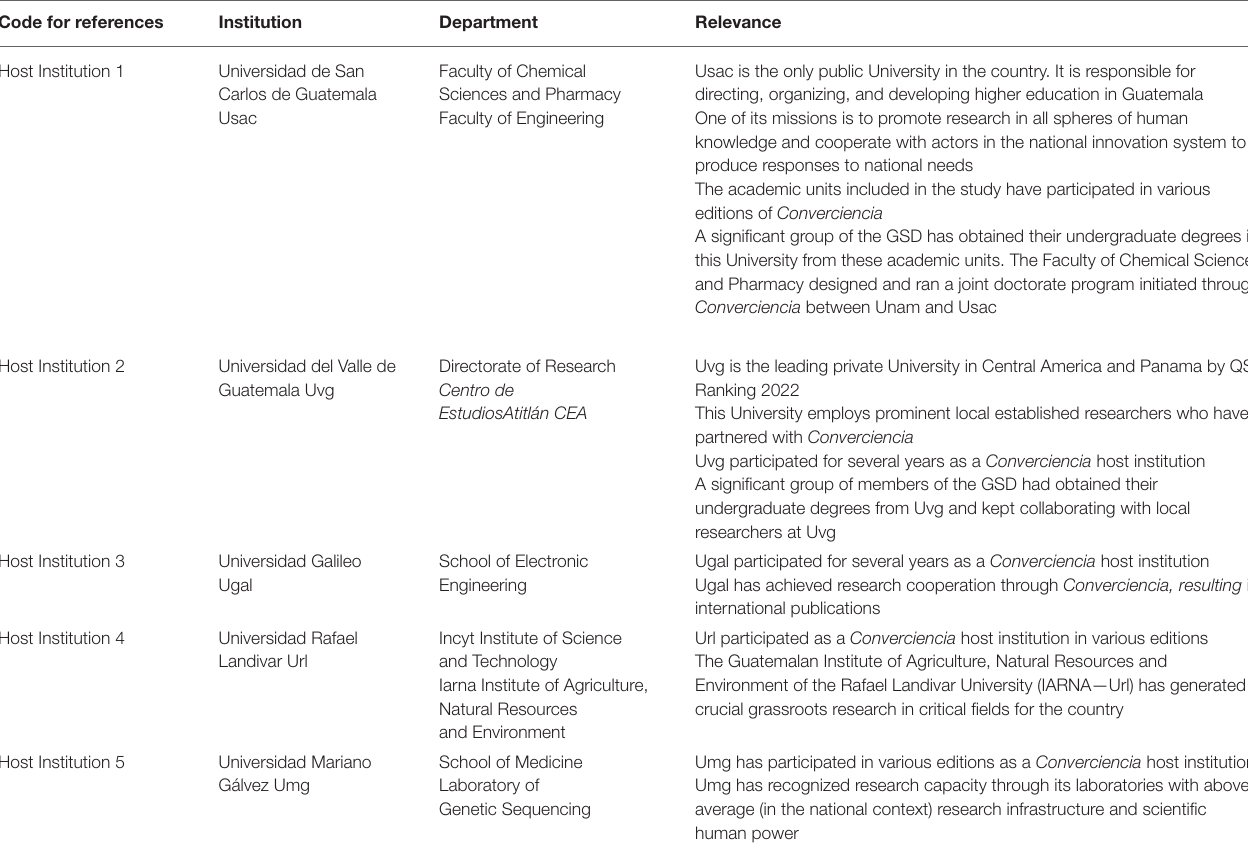
TABLE 4 | Selected host institutions: perspective for local partnerships for capacity building.